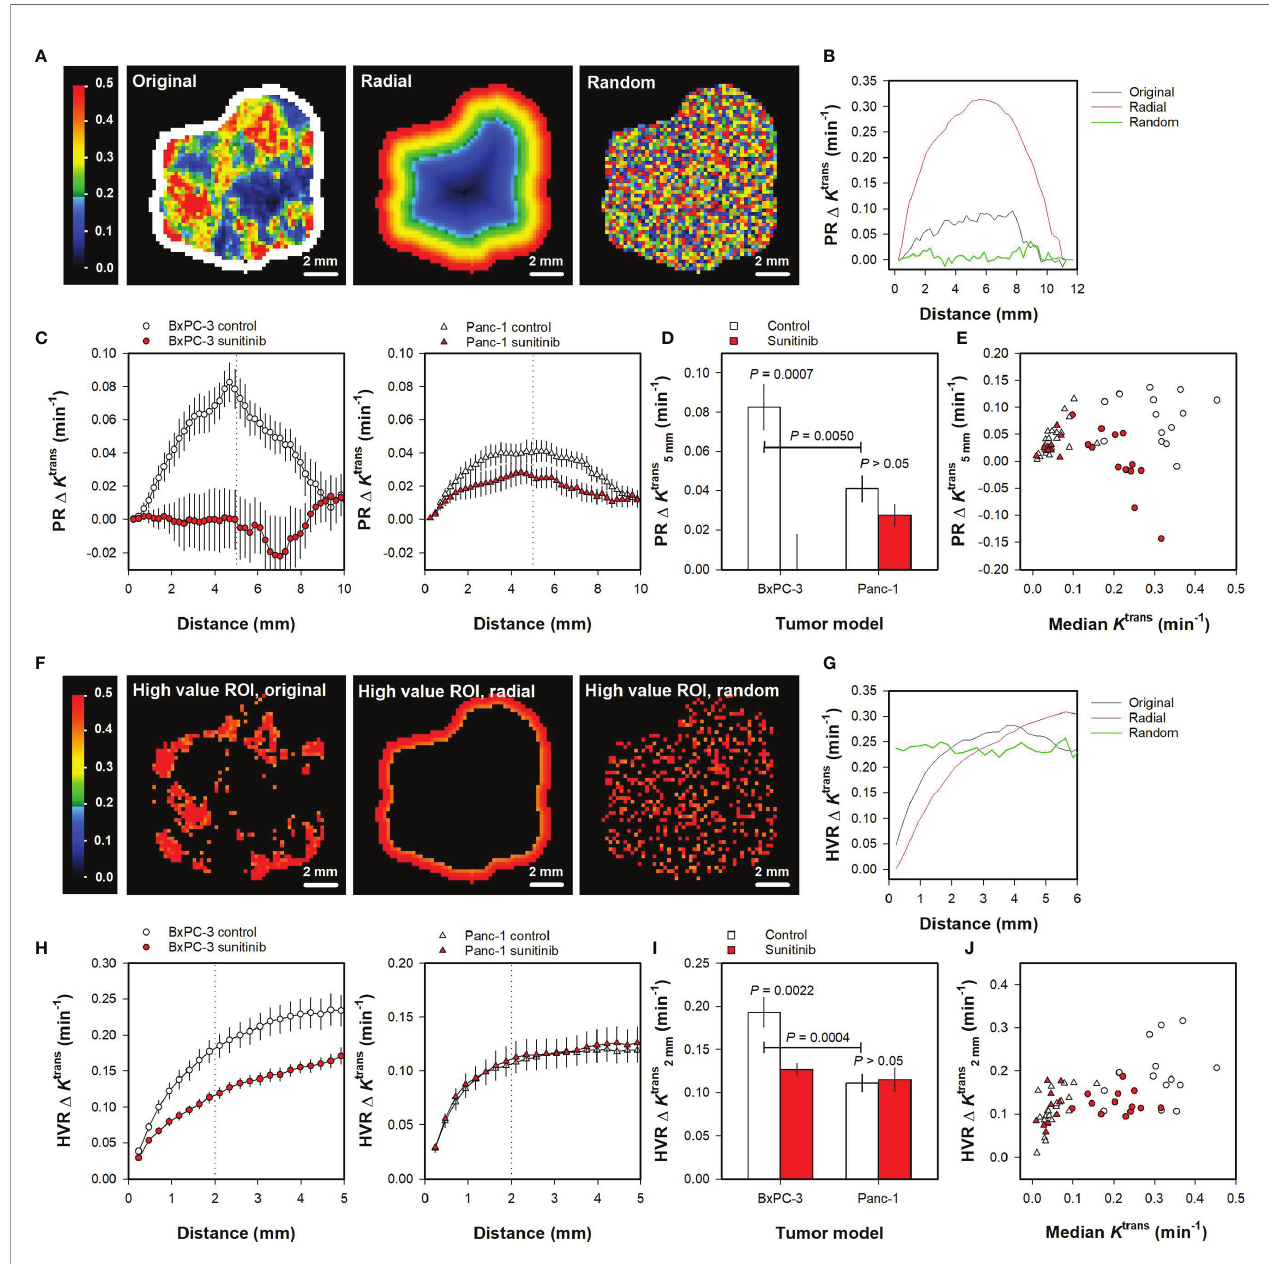
FIGURE 5 | (A) K trans maps of the representative untreated BxPC-3 tumor shown in Figure 1 . The K trans voxel values are shown in the original geometry and rearranged in a perfectly radial geometry and a random geometry. A peripheral region of interest (ROI) is shown in white color, and the K trans scale is given by the color bar. (B) The K trans gradient measured from the peripheral ROI (PR D K trans versus distance) for the untreated BxPC-3 tumor in the original, the perfectly radial, and the random geometry. (C) PR D K trans versus distance for untreated and sunitinib-treated BxPC-3 tumors and for untreated and sunitinib-treated Panc-1 tumors. Points and bars, mean ± SEM of 10-20 tumors. Dotted line indicate a distance of 5 mm. (D) PR D K trans measured at a distance of 5 mm (PR D K trans 5 mm ) in untreated and sunitinib-treated BxPC-3 tumors and in untreated and sunitinib-treated Panc-1 tumors. Columns and bars, mean ± SEM of 10-20 tumors. (E) PR D K trans 5 mm versus median K trans in untreated and sunitinib-treated BxPC-3 and in untreated and sunitinib-treated Panc-1 tumors. Points, individual tumors. (F) High value ROIs consisting of voxels with K trans values greater that the 75 th percentile for the representative untreated BxPC-3 tumor where the tumor voxels are arranged in the original geometry and rearranged in a perfectly radial and random geometry. The K trans scale is given by the color bar. (G) The K trans gradient measured from the high value ROIs (HVR D K trans versus distance) for the untreated BxPC-3 tumor in the original, the perfectly radial, and the random geometry. (H) HVR D K trans versus distance for untreated and sunitinib-treated BxPC-3 tumors and for untreated and sunitinib-treated Panc-1 tumors. Points and bars, mean ± SEM of 10-20 tumors. Dotted lines indicate a distance of 2 mm. (I) HVR D K trans measured at a distance of 2 mm (HVR D K trans 2 mm ) in untreated and sunitinib-treated BxPC-3 tumors and in untreated and sunitinib-treated Panc-1 tumors. Columns and bars, mean ± SEM of 10-20 tumors. (J) HVR D K trans 2 mm versus median K trans in untreated and sunitinib- treated BxPC-3 and in untreated and sunitinib-treated Panc-1 tumors. Points, individual